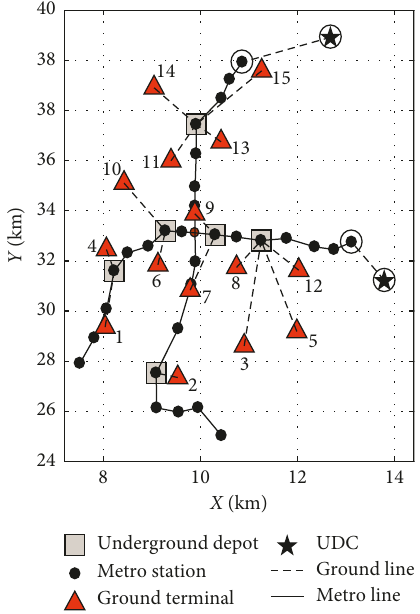
Figure 6: Optimal location-allocation of UD.